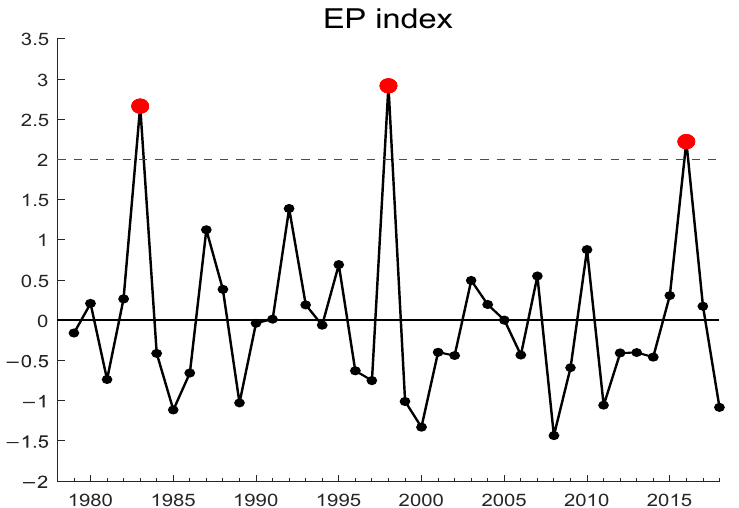
Figure 1. EP index (i.e., Niño-3 index) in January–February during 1979–2018. Red solid circles denote the decaying year of three extreme El Niño events: 1983, 1998, 2016.